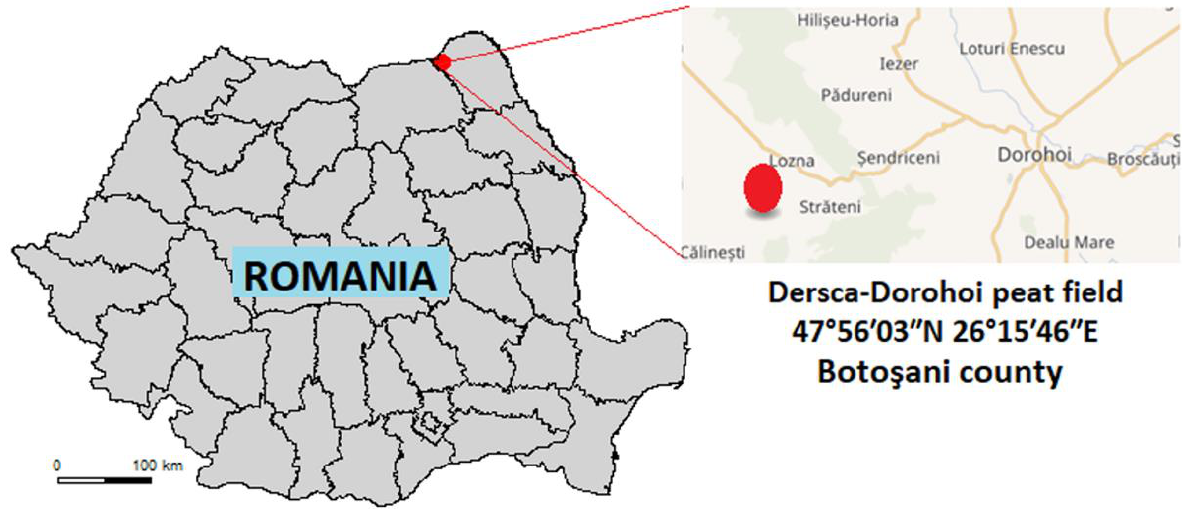
Figure 2. Dersca–Dorohoi peat field location map.